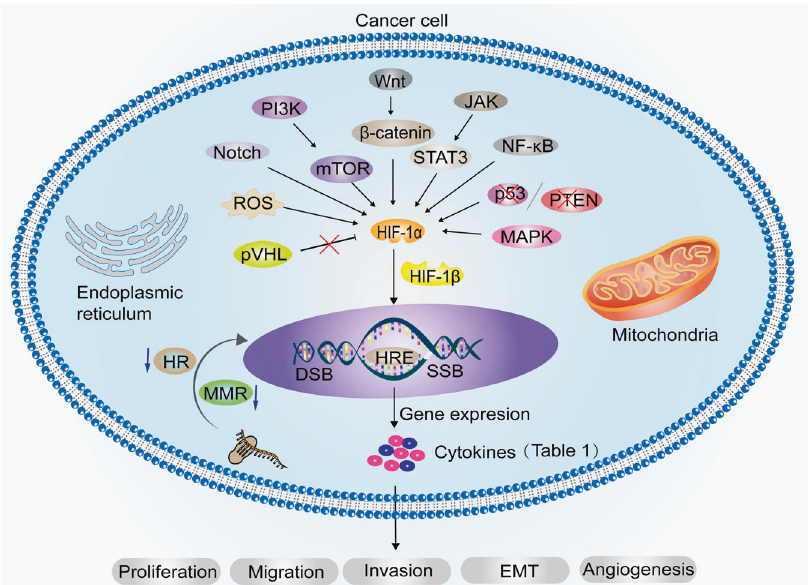
Fig. 3 Biological changes in cancer cells adapt to hypoxia. Hypoxia promotes carcinogenesis by inducing DNA strand breaks, including DNA DSB and SSB, and by weakening DNA repair pathways, such as HR and MMR. HIF-1 α is upgraded by PI3K-mTOR, JAK-STAT3, NF- κ B, MAPK, Wnt/ β -catenin, and Notch pathway. Deletion of tumor suppressor genes, such as p53, PTEN, and ROS production, also contributes to the upregulation of HIF-1 α . The loss of pVHL function under hypoxic conditions indirectly leads to HIF-1 α accumulation. HIF-1 α dimerizes with HIF-1 β and enters the nucleus to bind to HRE, which regulates various downstream target genes (Table 1) to promote cancer cell proliferation, migration, invasion, EMT and